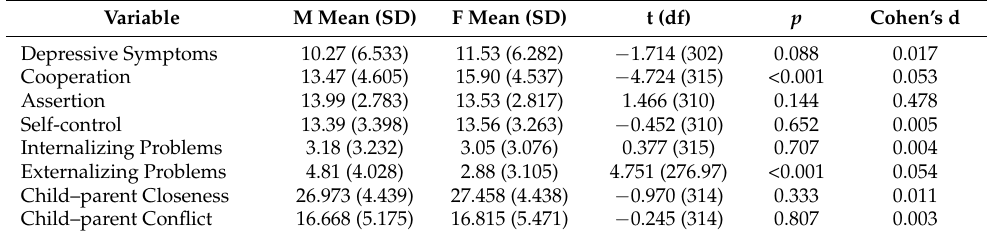
Table 1. Descriptive statistics and t -tests for gender differences in the study variables.